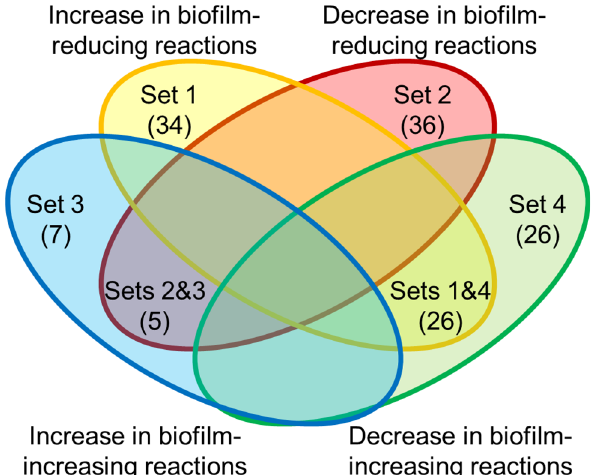
Fig 5. Definition of metabolite sets whose concentration changes were specific to either biofilm- reducing or biofilm-increasing reactions. The defined sets are as follows: set 1, metabolites that specifically increased when inhibiting biofilm-reducing reactions; set 2, metabolites that specifically decreased when inhibiting biofilm-reducing reactions; set 3, metabolites that specifically increased when inhibiting biofilm-increasing reactions; and set 4, metabolites that decreased when inhibiting biofilm- increasing reactions. Note that each metabolite set includes metabolites from two subsets of the Venn diagram. The number in parentheses indicates the number of metabolites in each